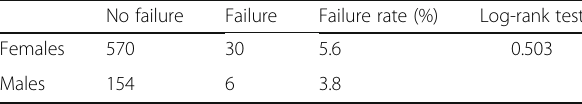
Table 6 Frequency distribution and the result of the χ 2